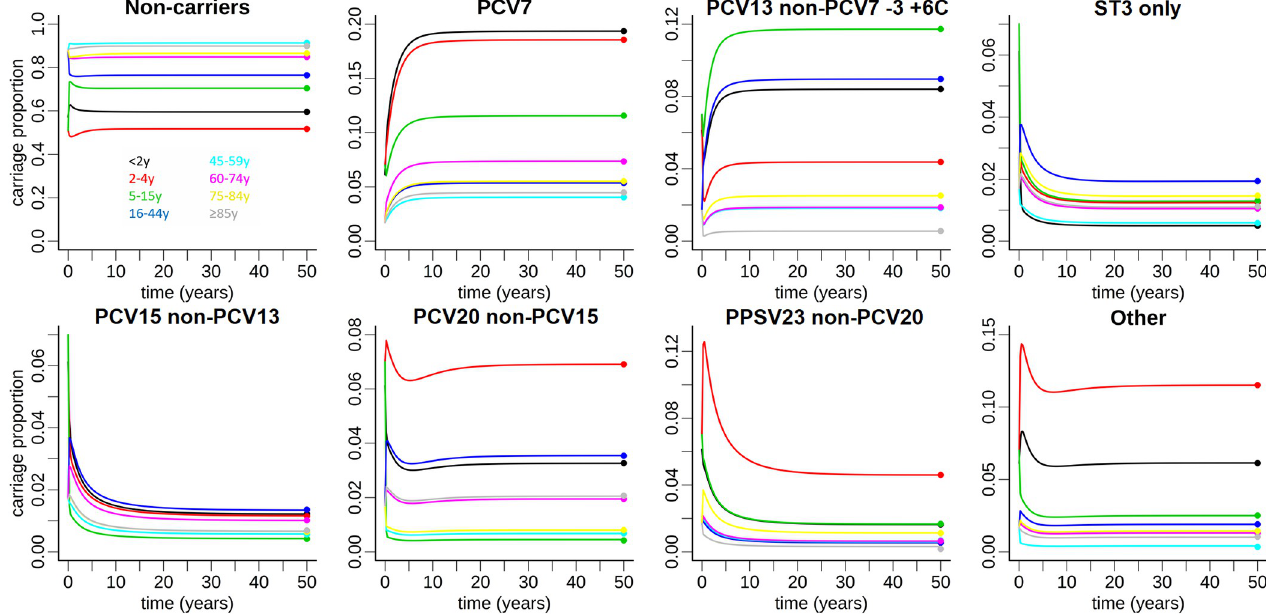
Fig 3. Results of the fitting process of the basic epidemiological model (i.e., without vaccinations). Initializing the model with arbitrary starting values, the model system was simulated for 50 years until a steady-state in all compartments was reached. The rightmost timepoint corresponds to the epidemiological year 2005/06 (pre-PCV vaccinations), where the agreement between model and data points (pneumococcal carriage proportions in Germany) was optimized. While the results are depicted separately for each serotype group (figure headings), age groups are visualized by colors: black ( < 2y), red (2-4y), green (5-15y), blue (16-44y), cyan (45-59y), purple (60-74y), yellow (75-84y), gray ( � 85y). Model oscillations due to the assumption of simultaneous aging were smoothed